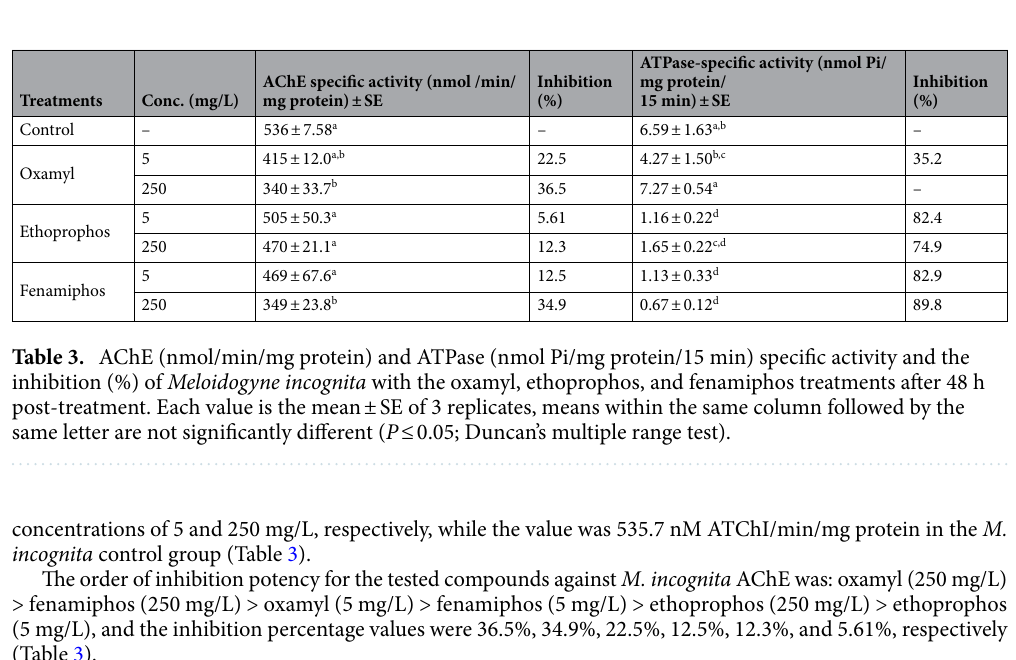
Figure 3. Percentages of M. incognita juveniles that were successfully located to their host roots after exposure to 2 ppm of the three nematicides.